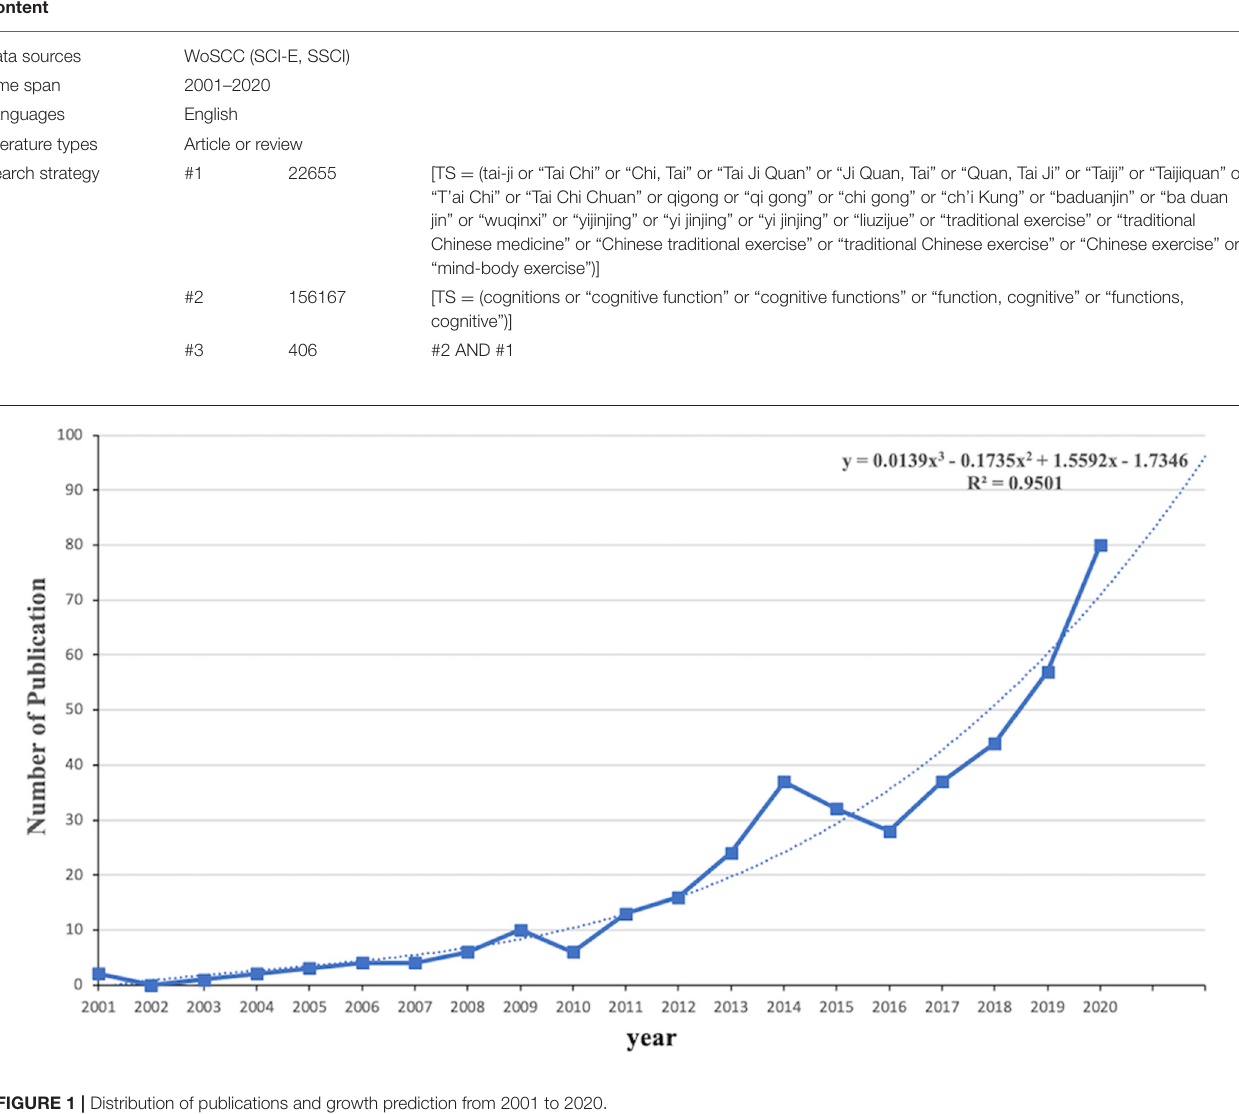
FIGURE 1 | Distribution of publications and growth prediction from 2001 to 2020. allowed us to capture different categories and examine their relationships in the field. (3) A prediction model [f(x) = ax 3 + bx 2 + cx + d] was then used to estimate future trends in research regarding TCHEs within the field of cognitive